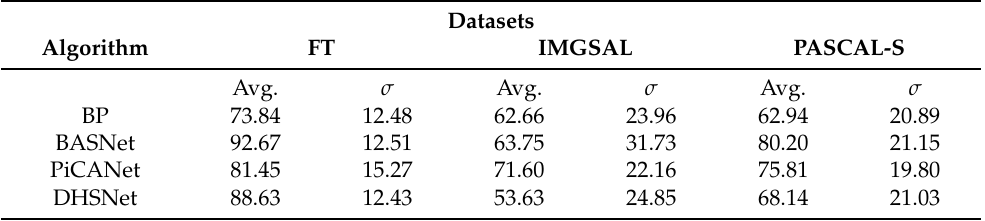
Table 21. Testing BP with GBVS against deep learning models for all databases. Since we are not combining the best programs with the segmentation step, the results are less performing for FT and PASCAL-S. However, this strategy is better for IMGSAL, as explained earlier. In general, we can say that the proposal is competitive compared to deep